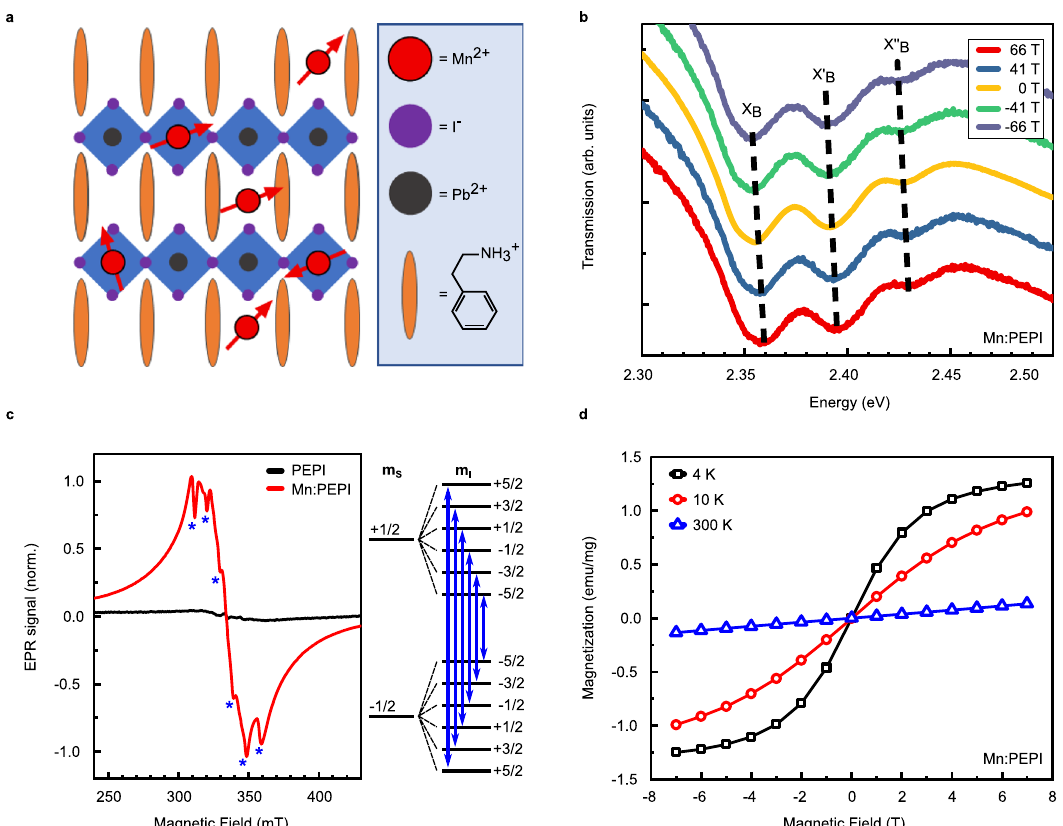
Fig. 1 Optical and magnetic characterization of Mn:PEPI. a Sketch of the Ruddlesden – Popper quantum well structure with two possible Mn sites: substitutional for the divalent anion and interstitial in the organic barrier. b Circularly polarized optical transmission at 4 K with the magnetic fi eld. The bright exciton and corresponding phonon replica are denoted X B , X B ‘ , X B ” , respectively. c Electron paramagnetic resonance response of drop casted material at 4 K. Stars denote the six hyper fi ne transitions. d SQUID magnetization versus fi eld sweep at different temperatures. The data shows that Mn 2 + ions are present in the crystal structure and give rise to paramagnetism without inducing additional optically active trap